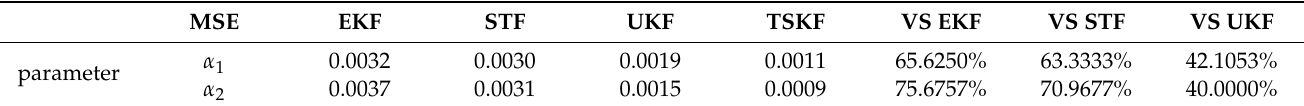
Table 4. Performance comparison of different algorithms.